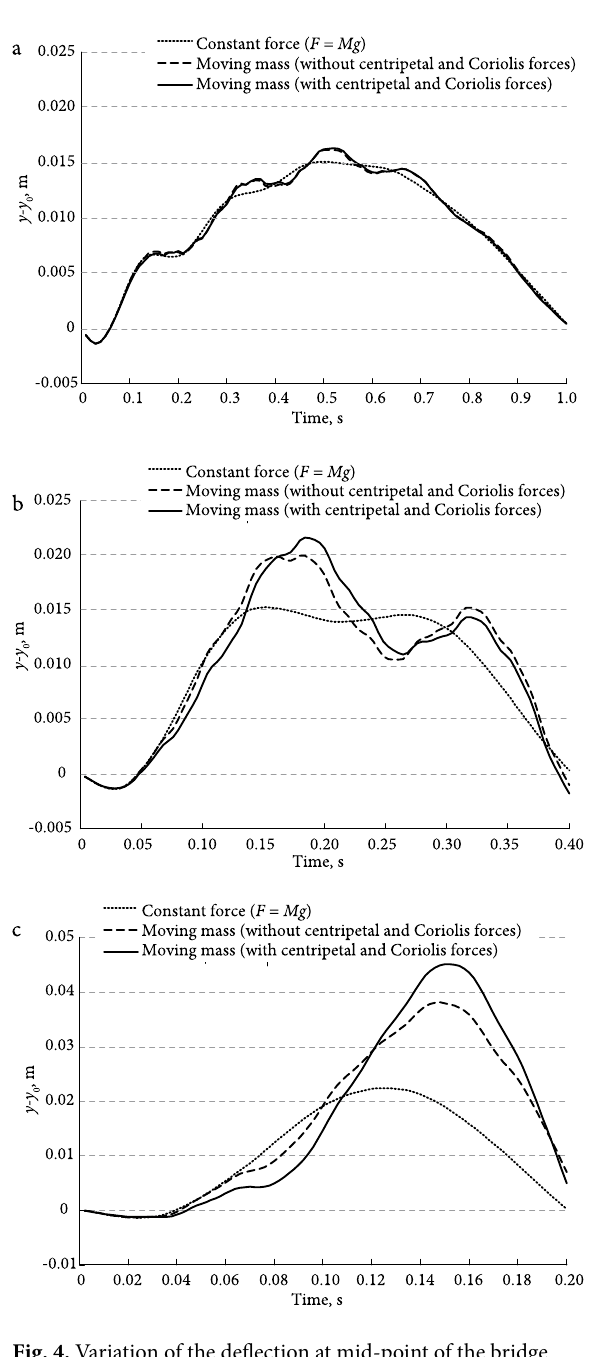
Fig. 4. Variation of the deflection at mid-point of the bridge with respect to time t ( A 0 = –0.1, convex bridge): a – v = 10 m/s; b – v = 25 m/s; c – v = 50